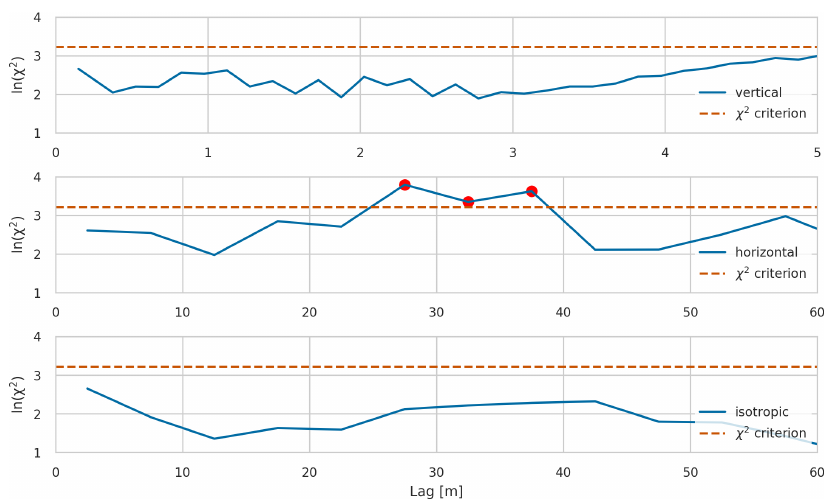
Figure 9. χ 2 − test with a significance level 0.05 in the vertical direction ( top ), the horizontal direction ( middle ), and the isotropic case ( bottom ). Distances with values larger than the χ 2 criterion (dash line) indicate dissimilar copula densities between two datasets (red points).